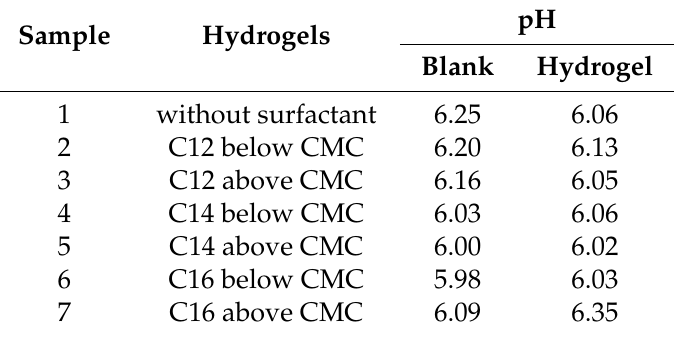
Figure 7. ( a ) Rheogram of hydrogel with C12 below the CMC: curve 1 -increasing, 2 -decreasing ( b ) Dependencies η = f ( τ ) curve I : C12, II : C14, and III : C16. Table 3. pH of chitosan hydrogels.